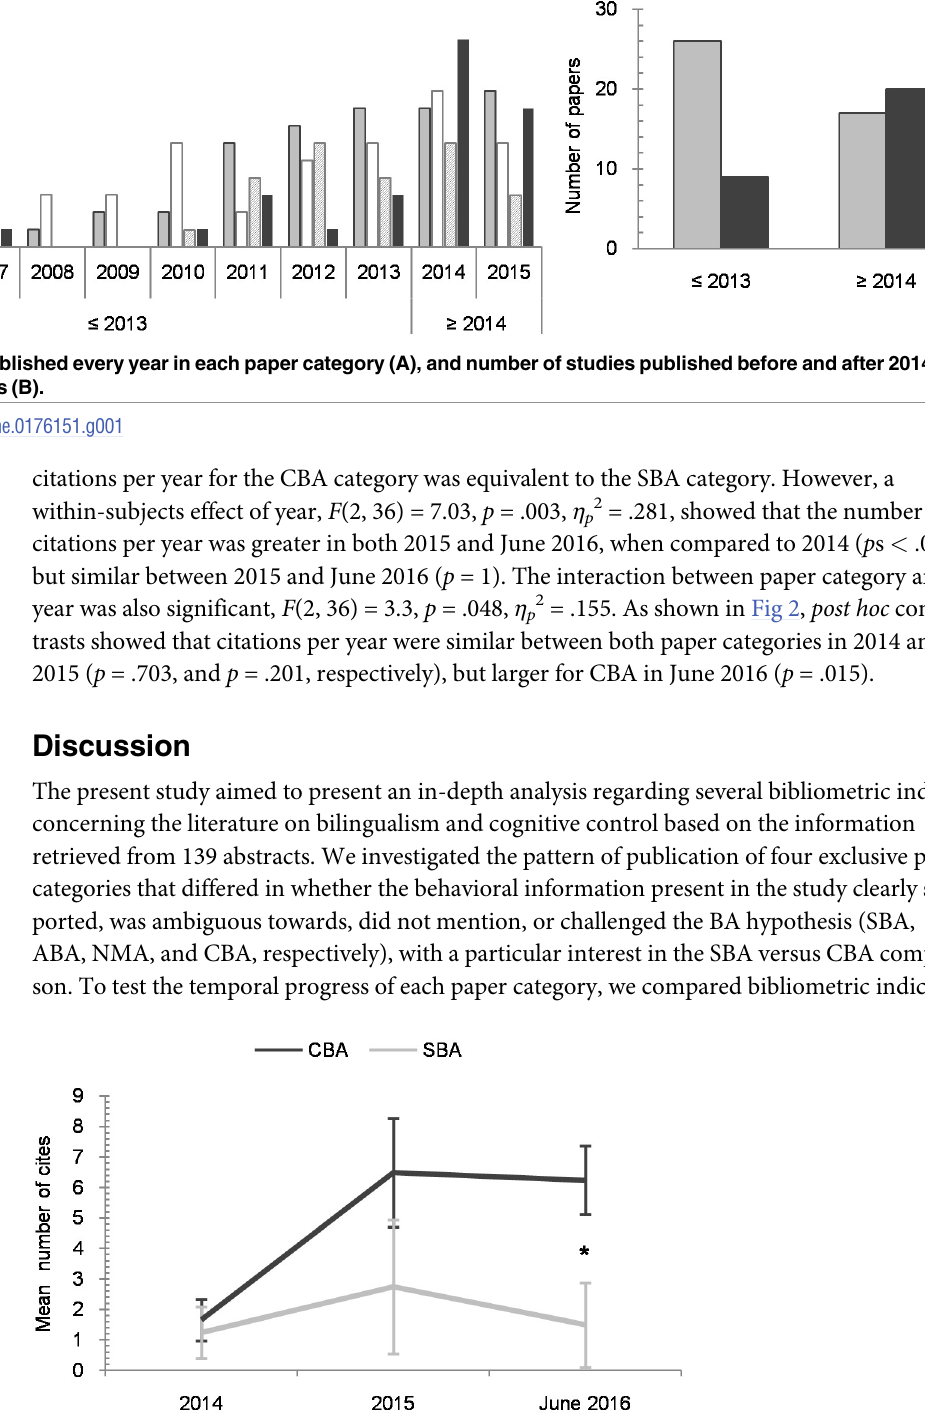
Fig 2. Temporal evolution of mean citations per year of SBA and CBA studies published in 2014. Error bars represent standard errors. Asterisk ( * p < .05) indicatesa significantdifference in cites per year between the SBA and CBA